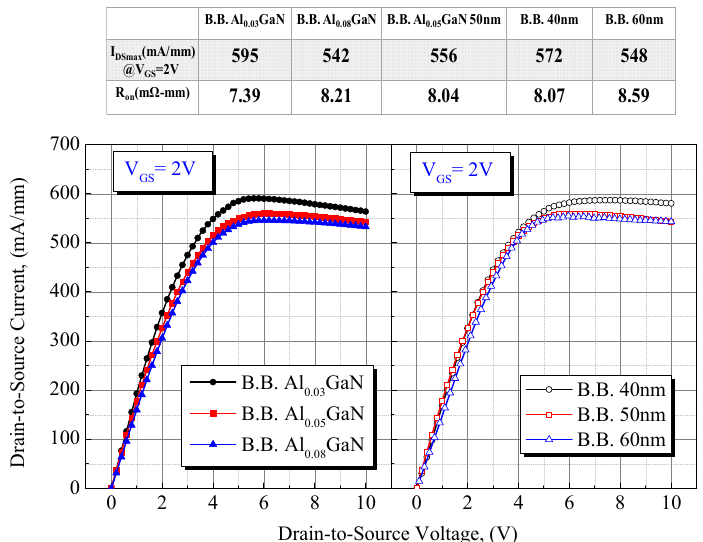
Figure 4. The measured I DS –V DS at V GS = 2V of devices.